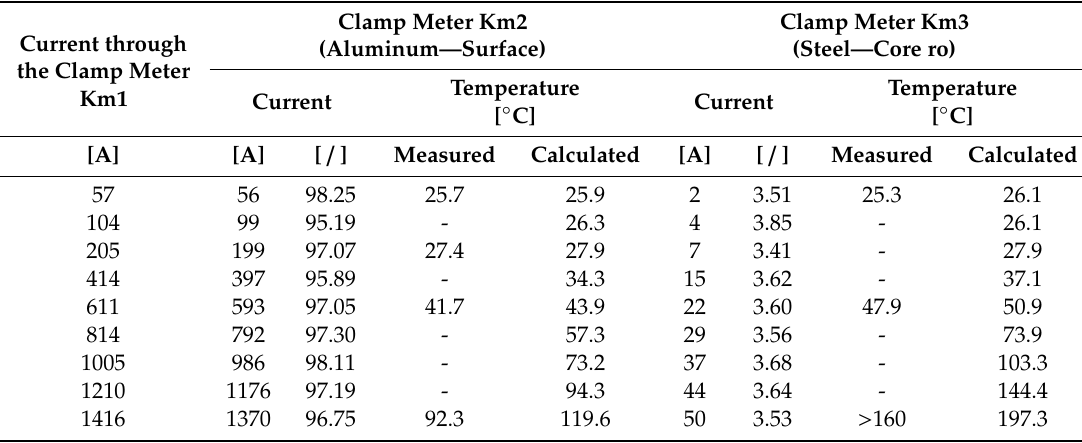
Table 5. Measured and calculated currents and temperatures at parallel binding of steel core and Aluminum coat taking into account the empty